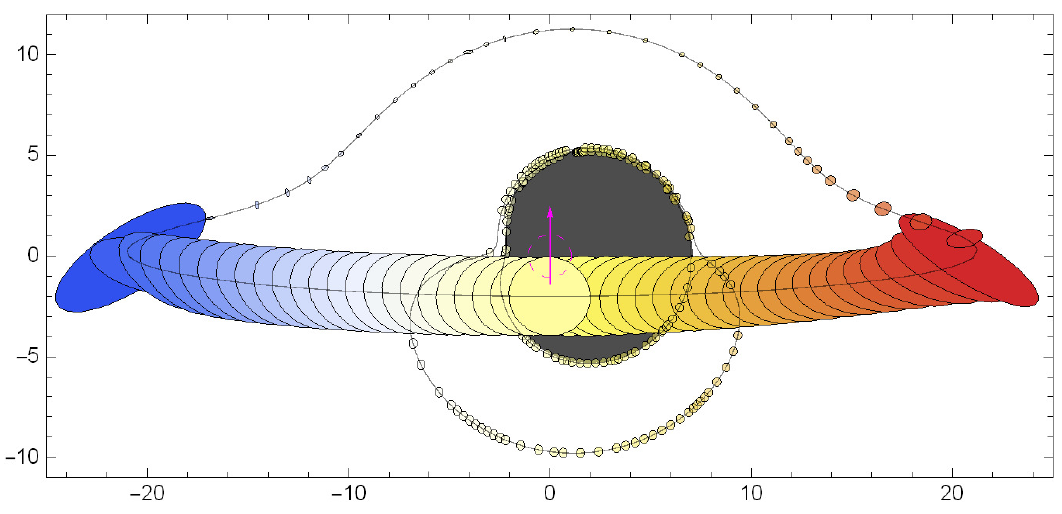
Figure 3. Direct images and also the first and second light echoes of the lensed compact star (luminous probe) in discrete times at the circular equatorial orbit with radius r = 20 around a near extreme black hole SgrA* viewed by a distant observer. All multiple images of this star are placed outside the classical black hole shadow (the closed black region). The dashed magenta circle is the projection of the black hole event horizon on the celestial sphere in the imaginary Euclidean space (in the absence of